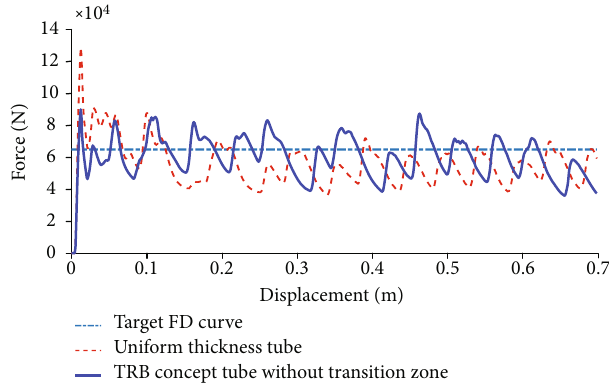
Figure 10: The FD curve of the uniform thickness tube and designed tube.